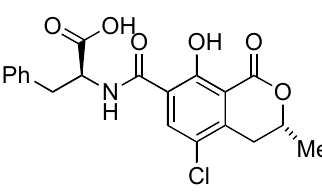
Figure 1. Molecular structure of Ochratoxin A.